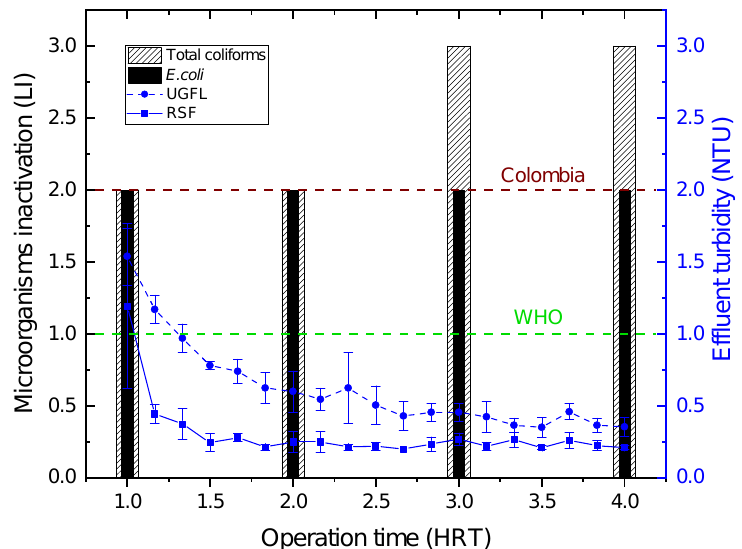
Figure 10. Test results for the evaluation of the removal of microorganisms (water type II, PACl and 1.0 m 3